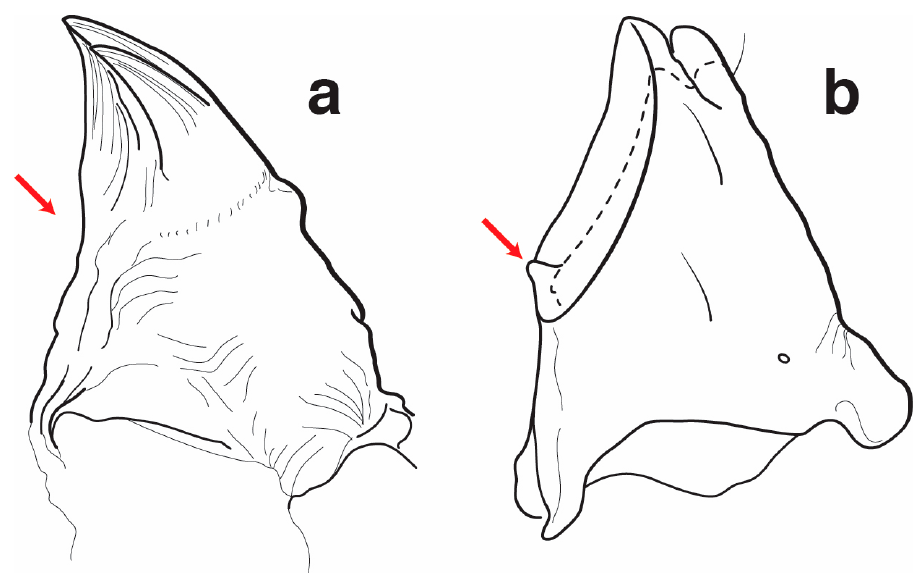
Figure 37. Mandible, larva: ( a ) Cyrtotrachelus ; and ( b ) Polytus .